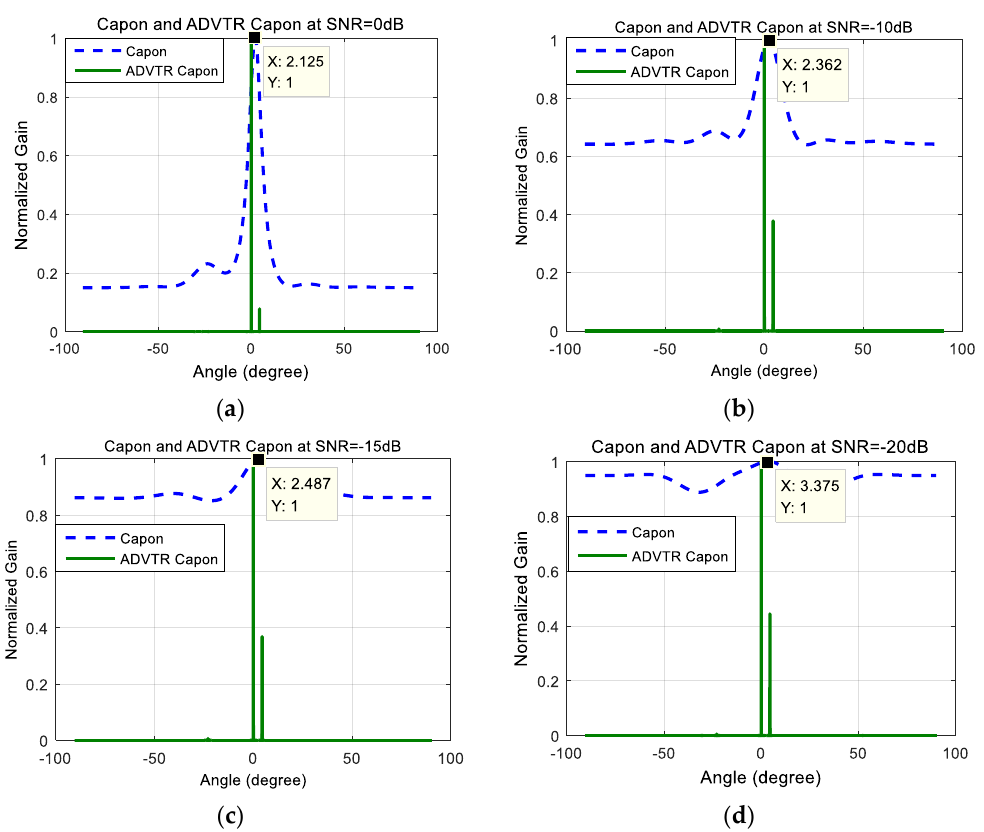
Figure 5. Capon estimator and ADVTR Capon estimator at θ = 0 ◦ . ( a ) SNR = 0 dB; ( b ) SNR = − 10 dB; ( c ) SNR = − 15 dB; ( d ) SNR = − 20 dB.